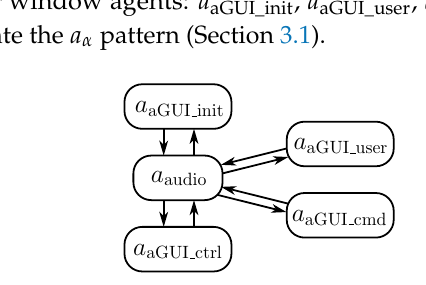
Figure 13. Structure of the audio